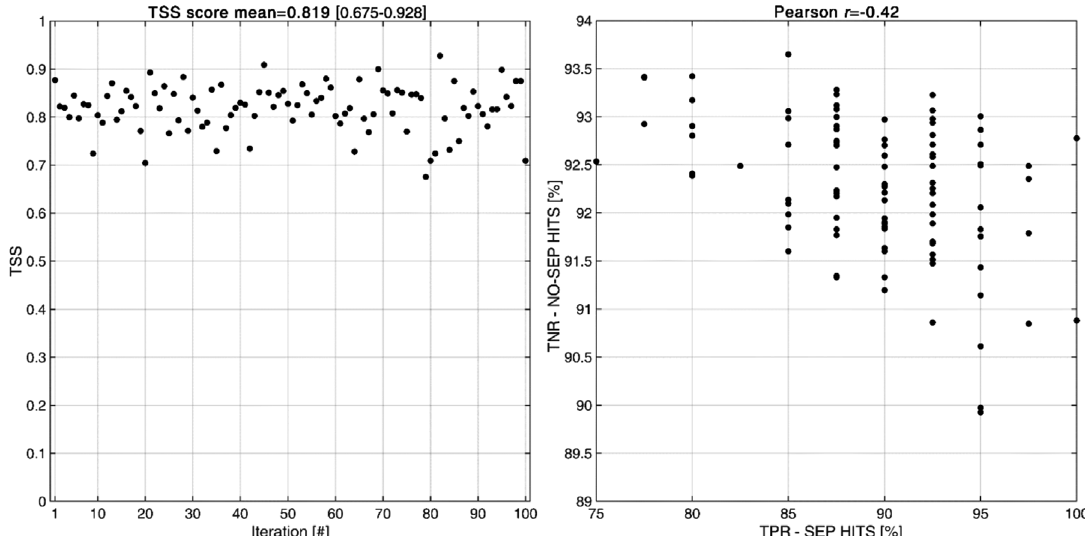
Fig. 4. Results from 100 iterations of random sampling-training-testing. Left panel: calculated True Skill Score with a high mean value. Right panel: cross-plot of TPR versus TNR showing a weak Table 1. Contingency matrix with mean percentages from the 100 evaluation iterations. Contingency matrix